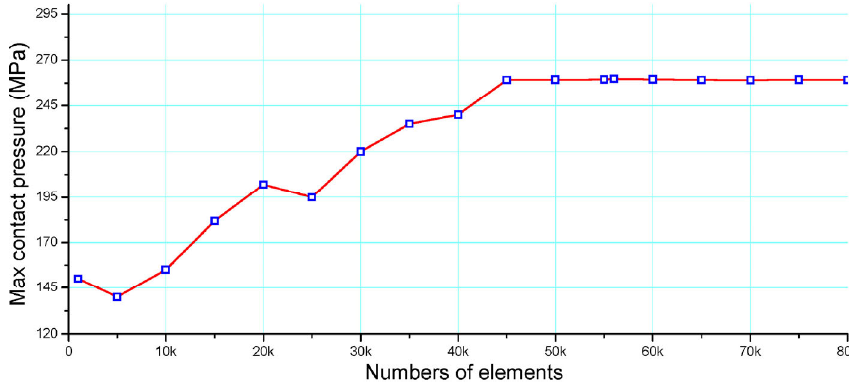
Fig. 6 Contact pressure obtained through convergence